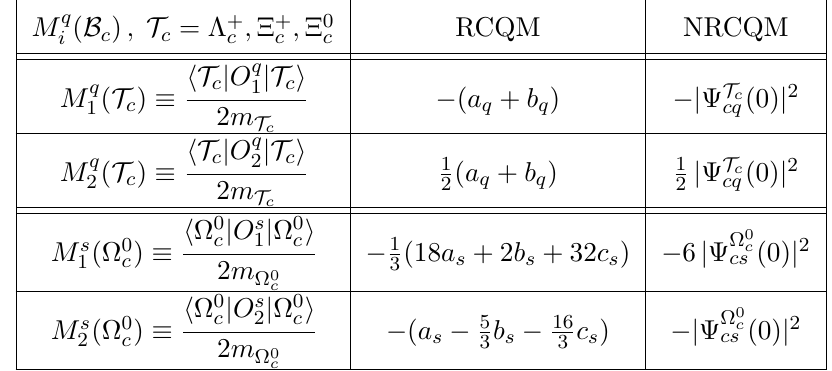
Table 13. Generalized parametrizations of dimension-six matrix elements for baryons in relativistic (RCQM) and nonrelativistic (NRCQM) constituent quark models [26, 40]. The definitions of a and c are in q